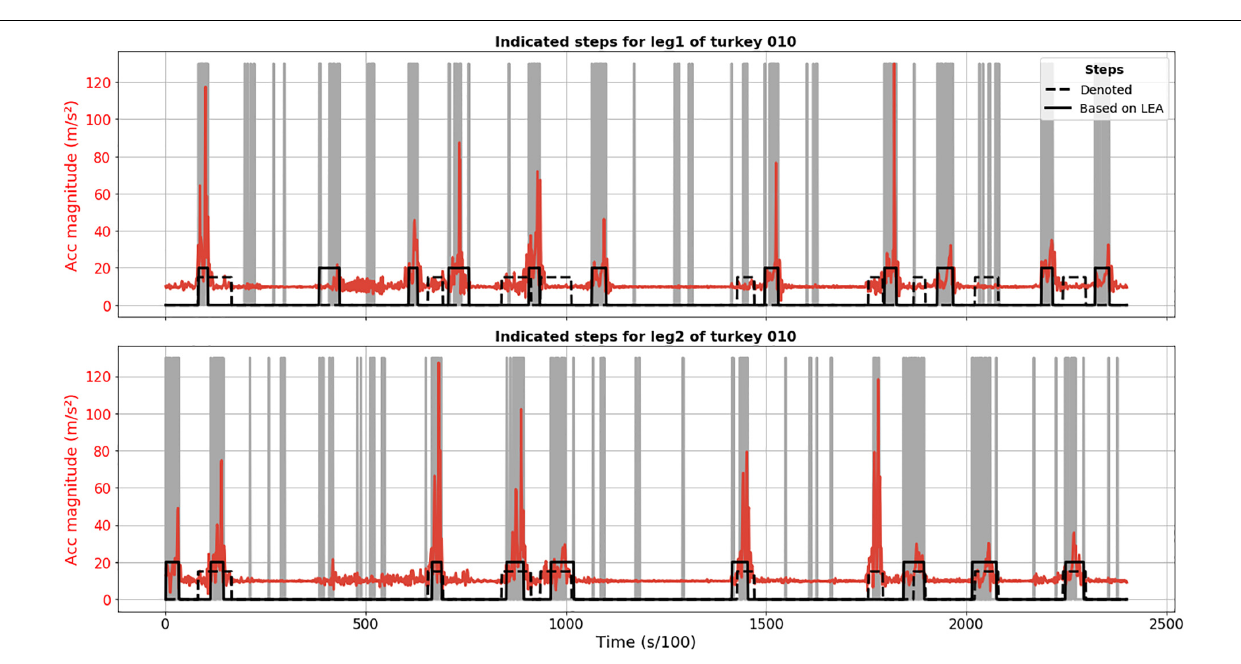
FIGURE 2 | Step segmentation results of LEA for turkey 010 (solid black line) for leg 1 (upper plot) and 2 (lower plot). Acceleration magnitude is plotted in red; dashed black line shows manually labeled steps. Vertical gray lines corresponded to important